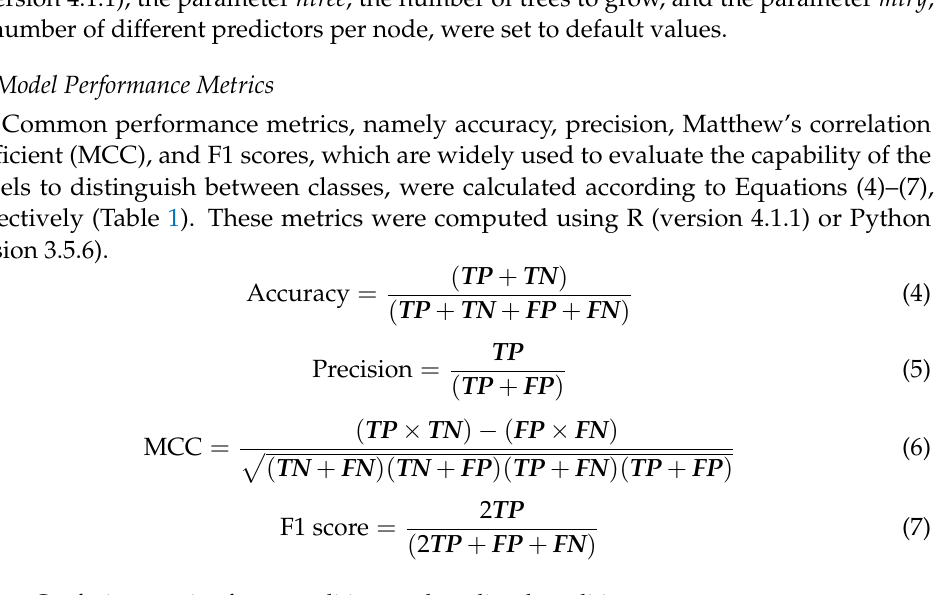
Table 1. Confusion matrix of true conditions and predicted